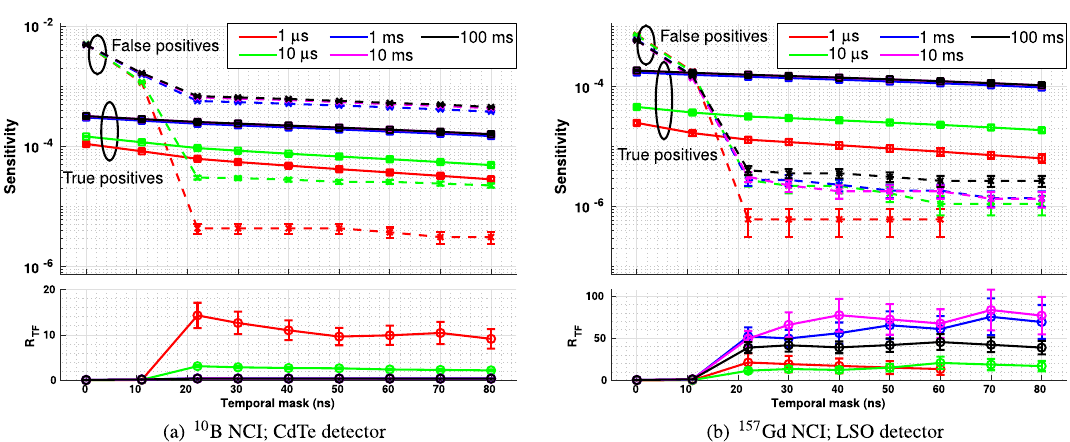
Figure 8. Sensitivity (upper plot) and R TF (lower plot) for photon detections only following target irradiation by a carbon ion beam as a function of temporal mask duration for a range of different irradiation periods. In all plots, the red markers denote a total irradiation time of 1 µs, green 10 µs, blue 1 ms, magenta 10 ms and black 100 ms. In the upper plots in each subfigure, square markers ( (cid:31) ) joined by unbroken lines denote true positives, while cross markers ( × ) joined by dashed lines denote false